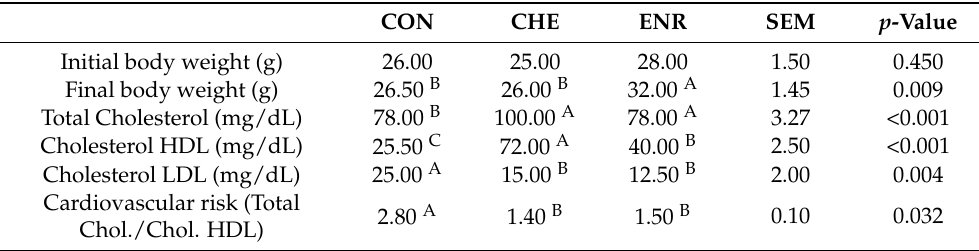
Table 2. Effect of the diet on body weight and blood composition. CON CHE ENR SEM p -Value Initial body weight (g) 26.00 Final body weight (g) Total Cholesterol